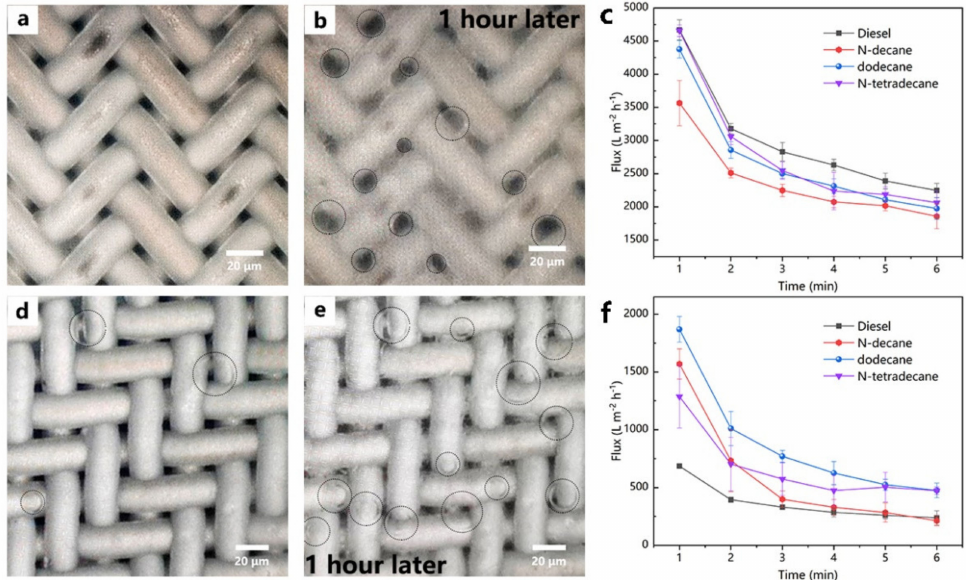
Figure 11. Image of metal fiber felt surface in the separation process of ( a ) oil-in-water emul- sions and ( d ) water-in-oil emulsions; ( b , e ) the performance oil–water separation through one hour; ( c , f ) variation of separation fluxes with each